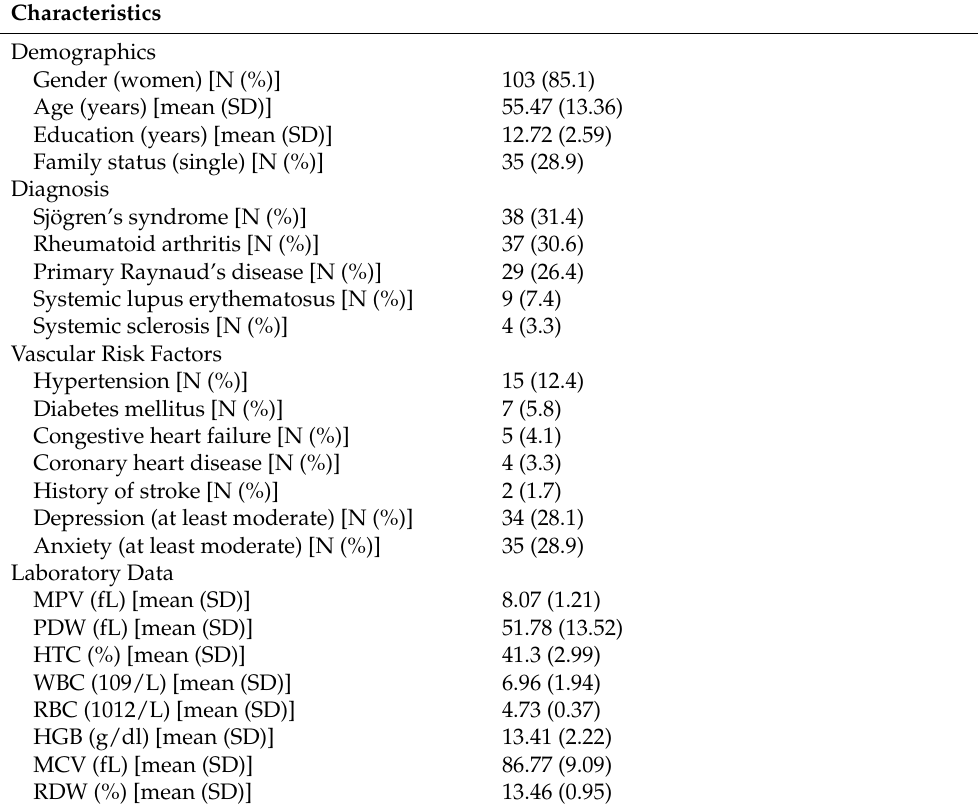
Table 1. Demographic and Clinical Characteristics of